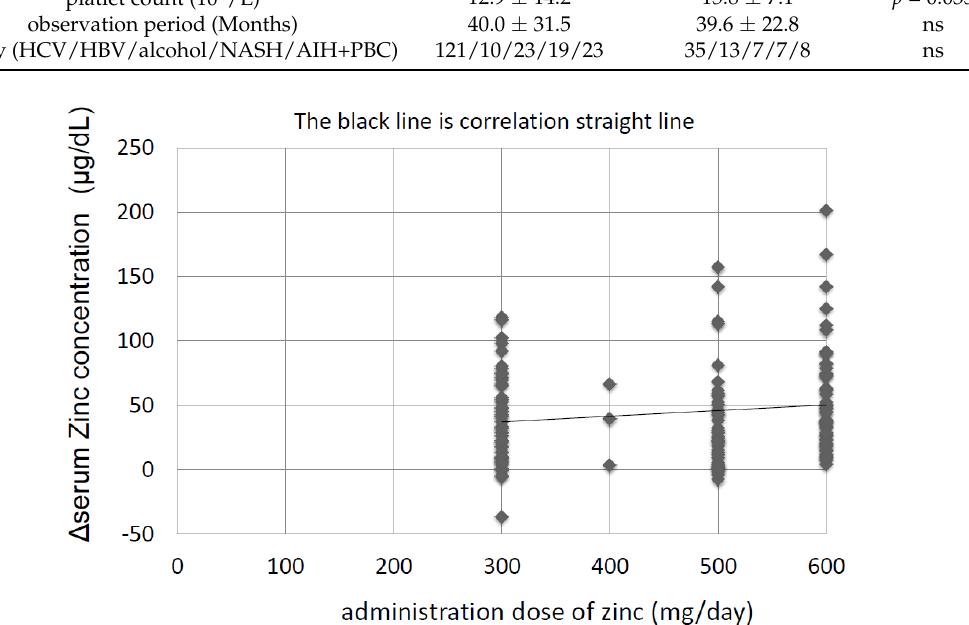
Figure 1. Relationships between the administered dose of zinc and the increase in serum zinc concentration. ΔZn = Zn concentration (6 months after treatment) − Zn concentration (before treatment), ΔZn = 0.044 × (Zn dose) + 23.8, R = 0.14, p = 0.023. A weak relationship exists between the administered dose of zinc and the increase in serum zinc concentration.